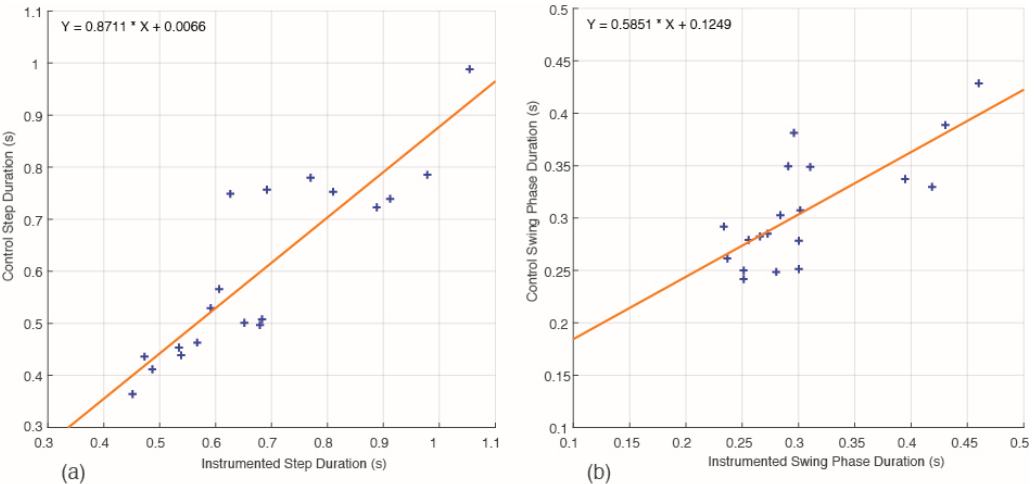
Figure 7. ( a ) Pearson’s correlation between Control and Instrumented step duration (r = 0.88); ( b ) Pearson’s correlation between Control and Instrumented swing duration (r = 0.76).